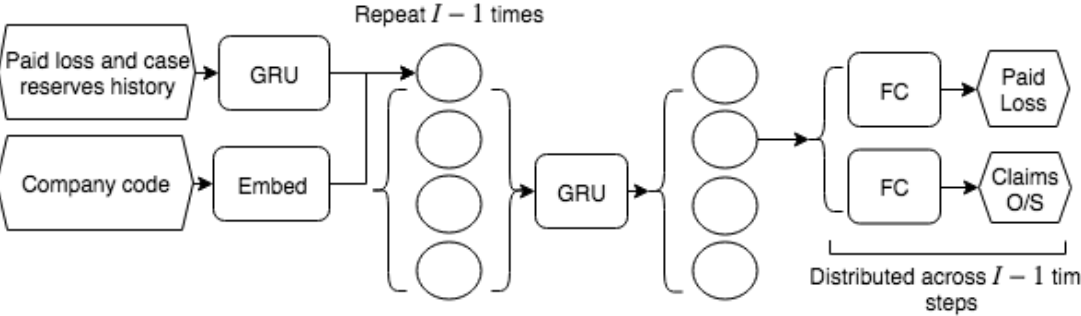
Figure 2. DeepTriangle architecture. Embed denotes embedding layer, GRU denotes gated recurrent unit, FC denotes fully connected